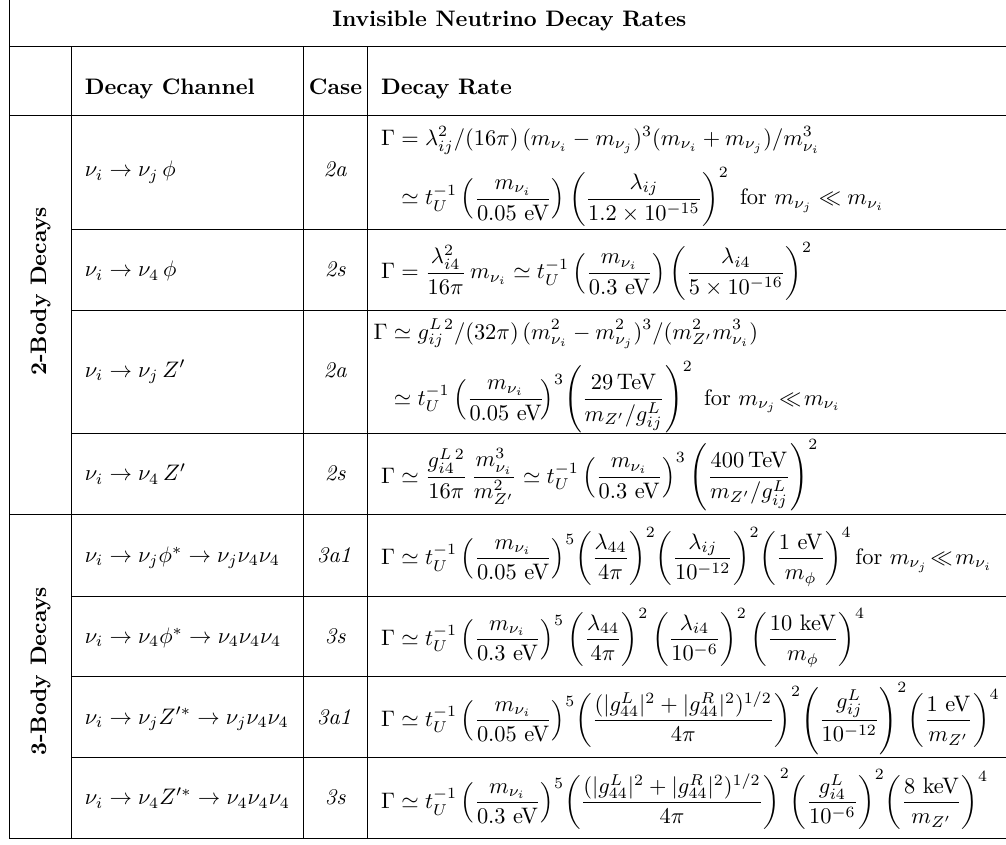
Table 2 . Rates for invisible neutrino decays. For neutrinos coupled to a scalar we have con- sidered pseudo-scalar couplings only for concreteness. We have simplified the 3-body decay rates by integrating out the mediating boson and φ/Z 0∗ means off-shell mediators. See appendix A for detailed formulae. The reference numbers for each decay are chosen so as to match relevant scales/parameters, see section